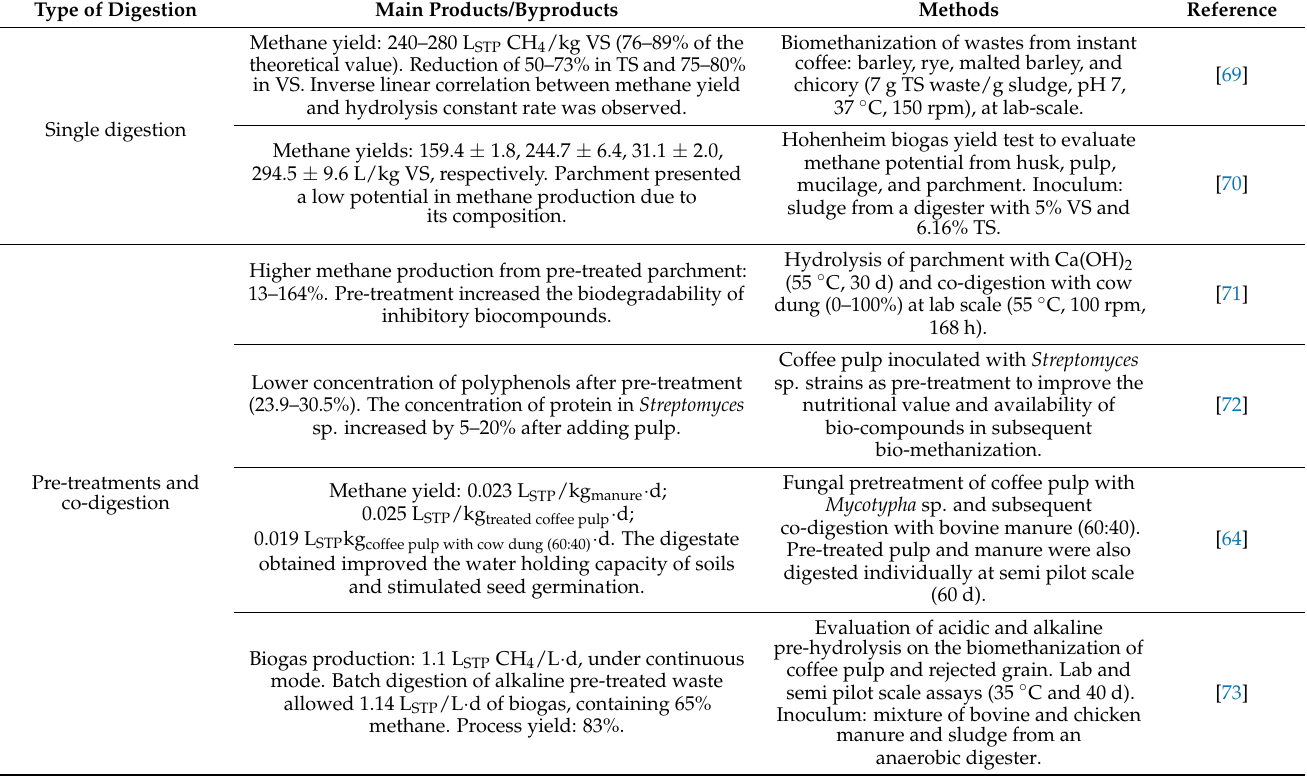
Table 3. Biomethanization of wastes and by-products derived from primary coffee